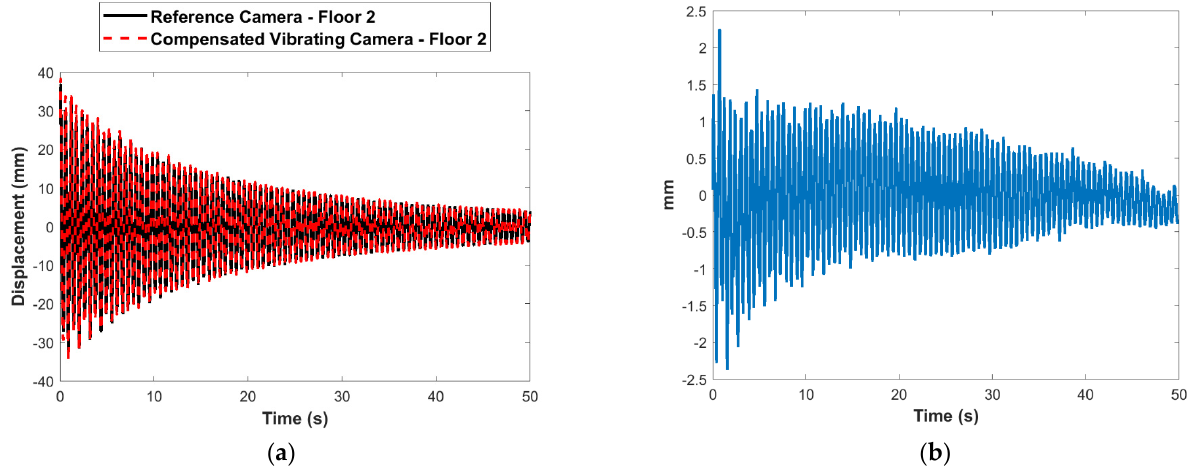
Figure 14. Comparison of estimated and reference second-story displacement: ( a ) in time domain after compensation of vibrating camera; ( b ) errors after compensation of vibrating camera.